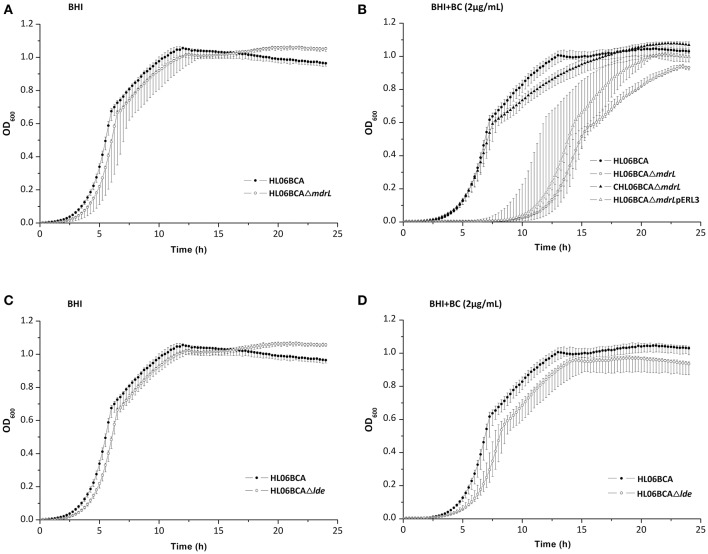
(A) Growth curves for L. monocytogenes HL06BCA and HL06BCAΔmdrL in BHI broth. (B) Growth curves for L. monocytogenes HL06BCA, HL06BCAΔmdrL, CHL06BCAΔmdrL, and HL06BCAΔmdrLpERL3 in BHI broth with 2 μg/mL of BC. (C) Growth curves for L. monocytogenes HL06BCA and HL06BCAΔlde in BHI broth. (D) Growth curves for L. monocytogenes HL06BCA and HL06BCAΔlde in BHI broth with 2 μg/mL of BC.